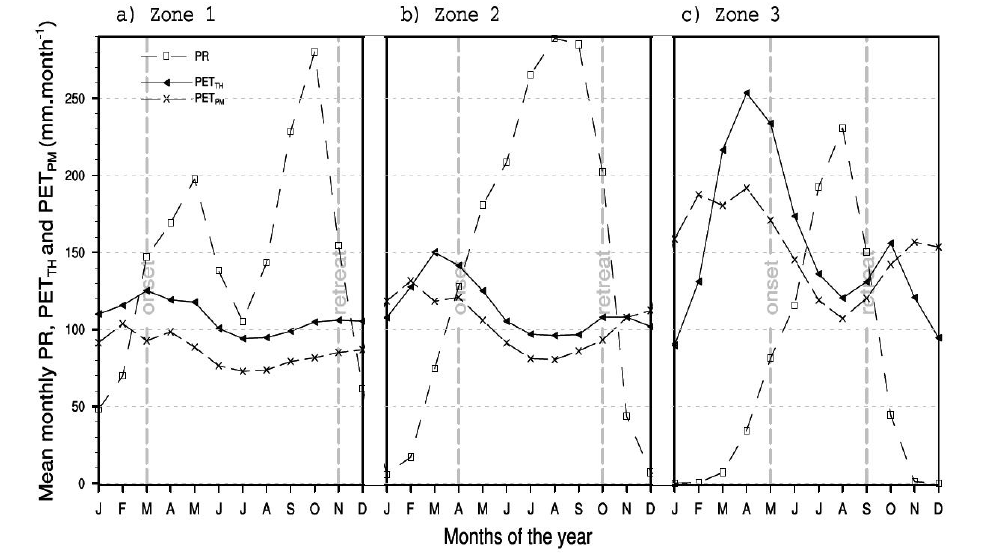
Figure 3. Annual cycles of mean monthly PR and PET (expressed in mm · month − 1 ) for the period 1962–1993: ( a ) for the Equatorial forest zone named Zone 1 (south of study area); ( b ) for the transition zone between the Equatorial forest zone and the Sahel zone named Zone 2; and ( c ) for the Sahelian zone named Zone 3 (north of study area). For each zone, there are two gray vertical dashed lines representing the mean onset and retreat month of the rainy season [30]. These months are absolutes and correspond to those containing onset and retreat dates in terms of pentads and their variabilities (not more than six pentads for the highest range). PET are from the Thornthwaite and Penman–Monteith methods. The labels on the x-axis (J, F, ..., D) indicate the months of the year (January, February, ..., December)